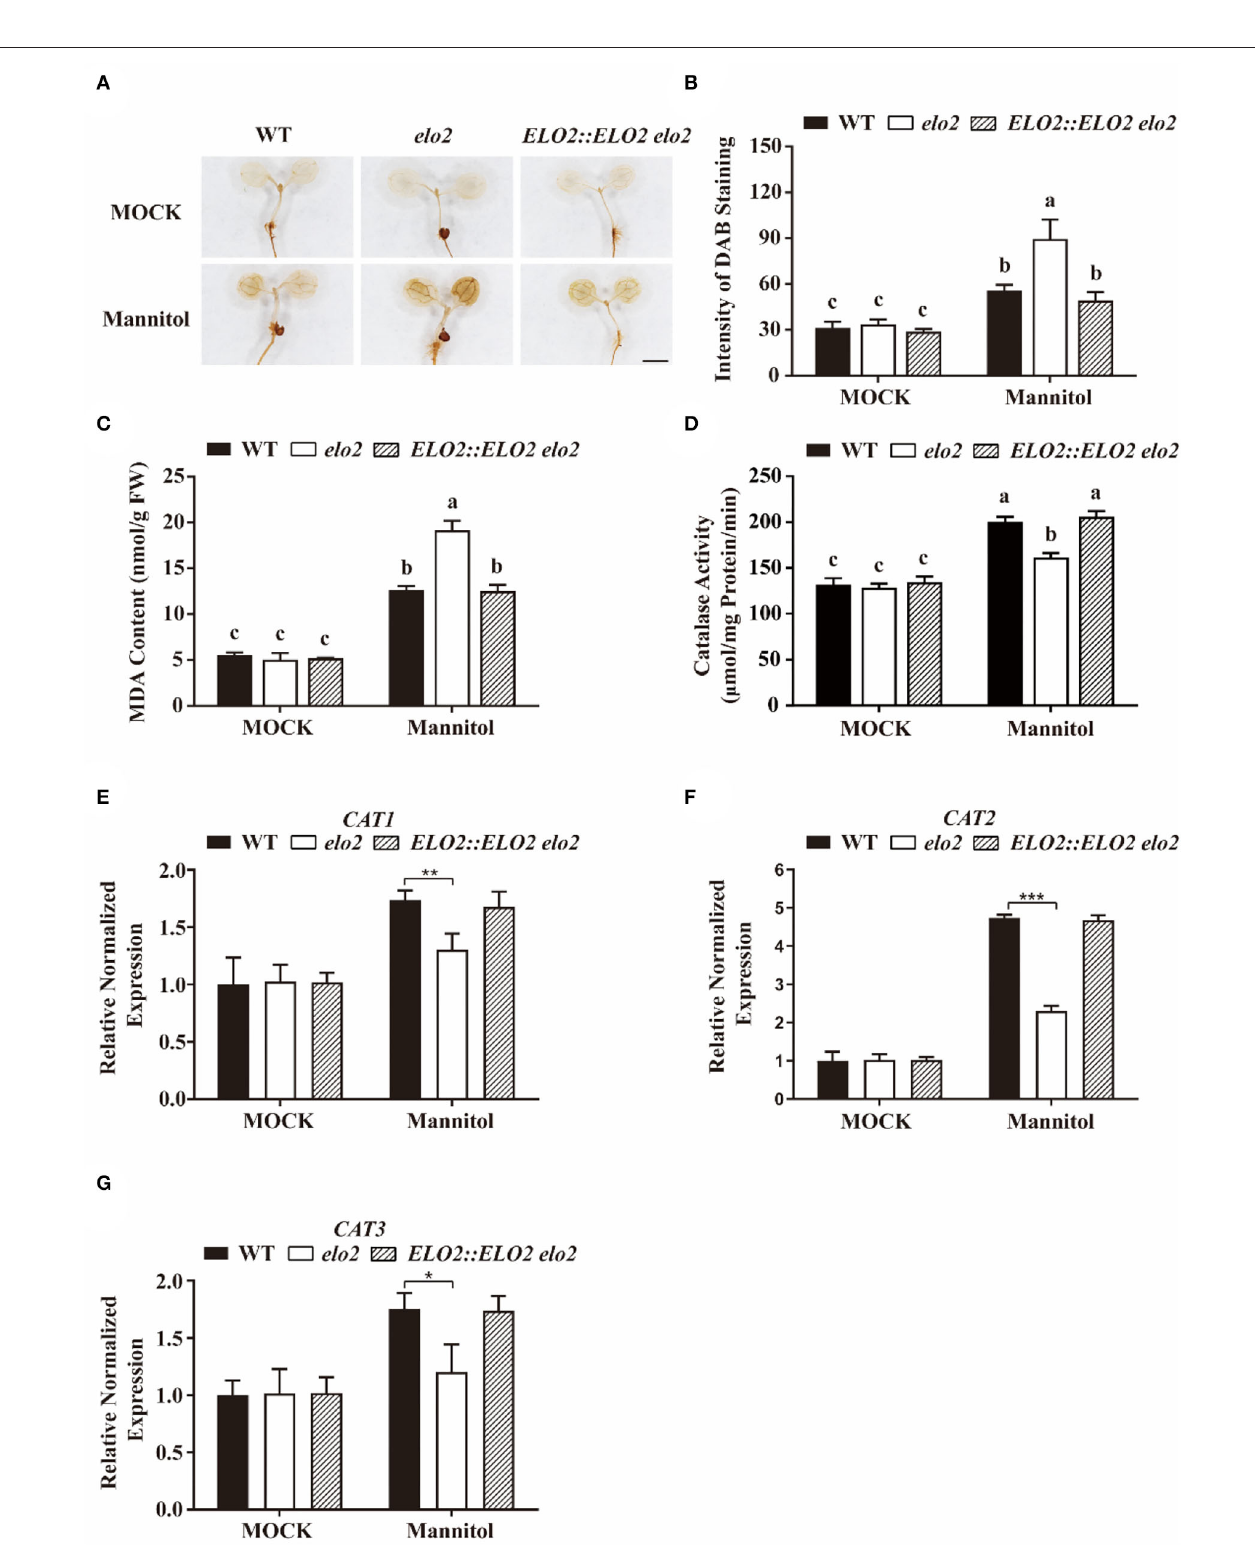
FIGURE 5 | ELO2 modulates catalase activity and thus H 2 O 2 accumulation in plant osmotic stress response. (A,B) Representative images (A) and intensity of DAB staining (B–G) MDA content (C) , catalase activity (D) , and relative normalized expression of CAT1 (E) , CAT2 (F) , CAT3 (G) in 5-day-old WT, elo2 , and